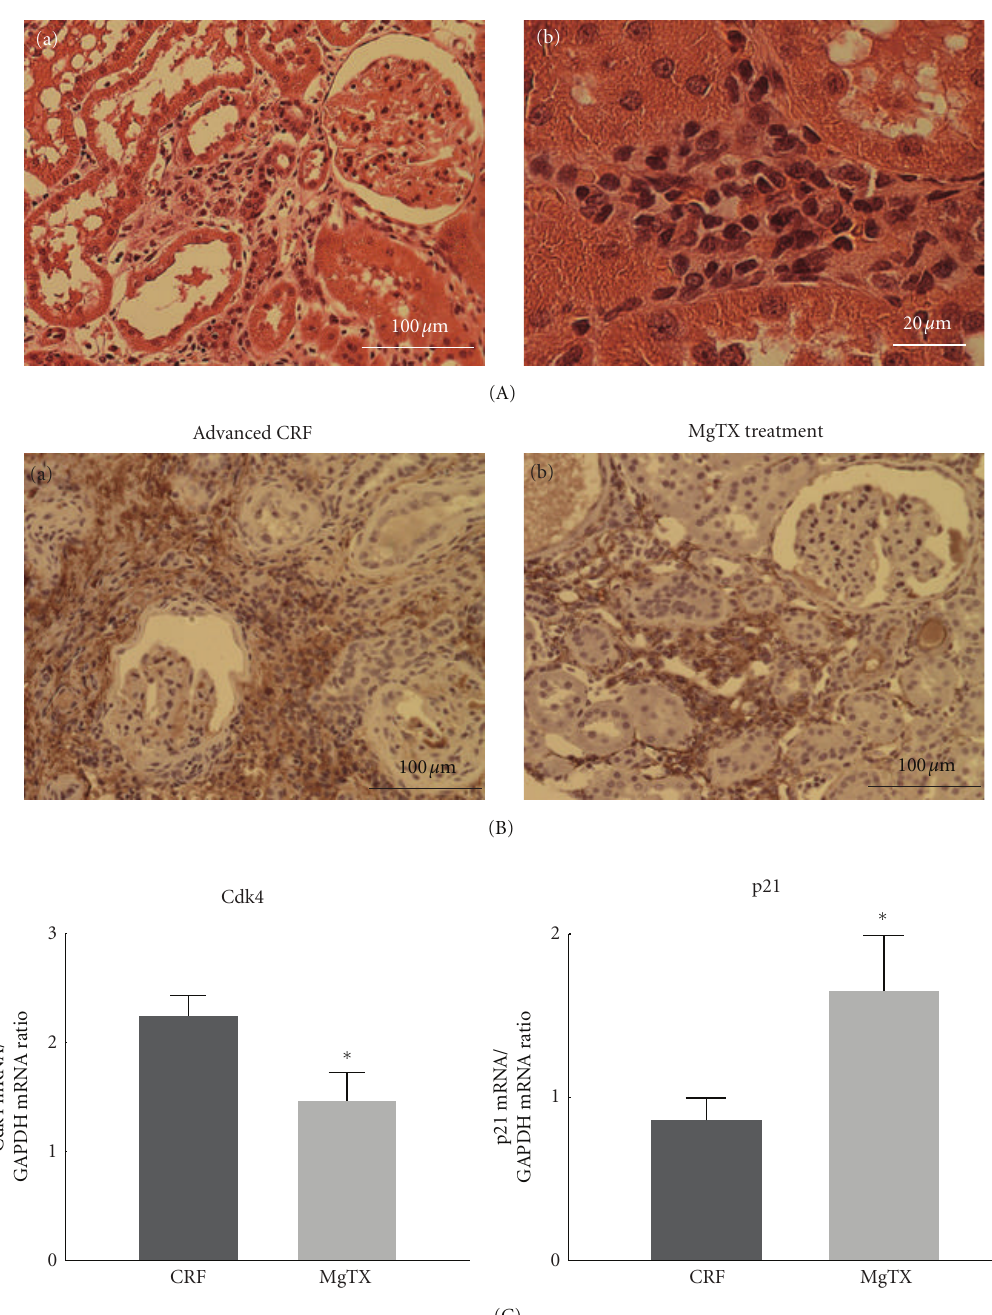
Figure 3: Collagen III and cell cycle marker expression in advanced CRF rat kidneys after margatoxin (MgTX) treatment. (A) Hematoxylin and eosin staining (H&E) in advanced CRF rat kidneys after margatoxin (MgTX) treatment. (a) A low-power view of cortex. Magnification, × 20. (b) A high-power view of cortical interstitium. Magnification, × 60. (B) Immunohistochemistry using antibody for collagen III (brown) in advanced CRF rat kidneys with and without MgTX treatment. (a) and (b) Low-power views of cortex. Magnification, × 20. (C) Cell cycle marker expression. The mRNA abundance of Cdk4 (left) and p21 (right) in the renal cortex of advanced CRF rat kidneys with and without MgTX treatment. ∗ P < 0 . 05 versus advanced CRF rats without treatment. Values are means ± SEM ( n = 6). Di ff erences were analyzed by ANOVA followed by Dunnett’s or Student’s t